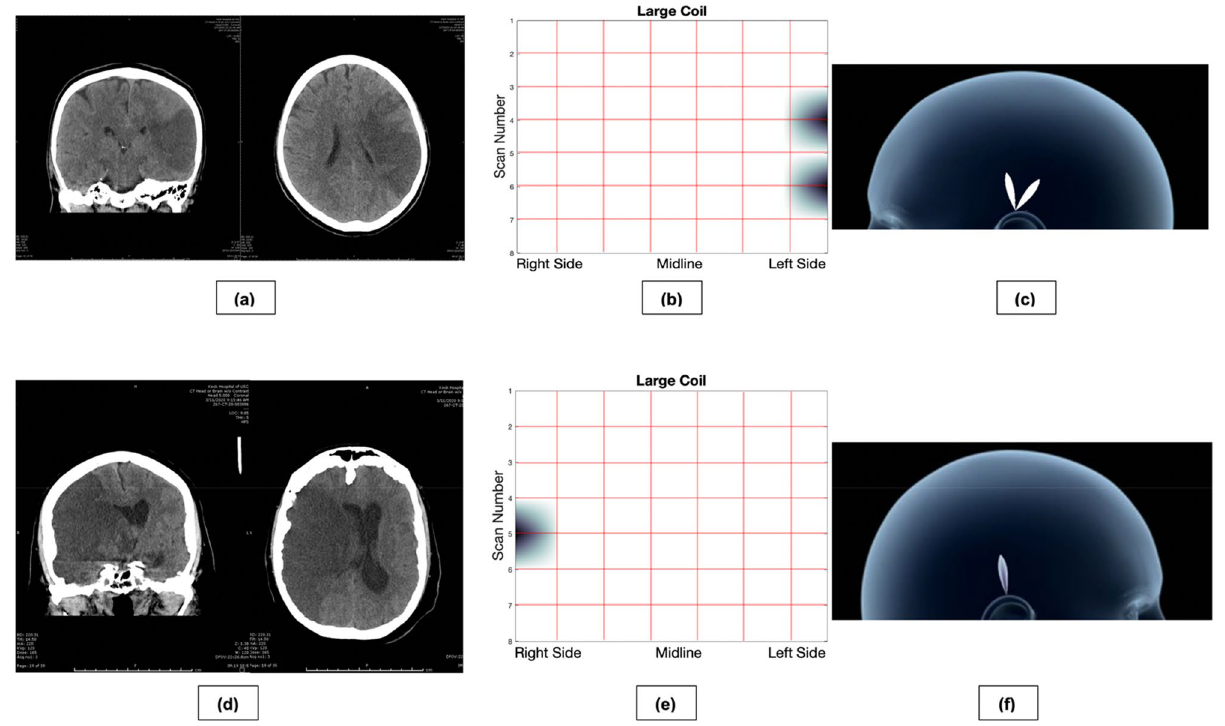
Figure 5. CT imaging, 2D ECD sensor imaging, and 3D ECD sensor imaging for two ischemic stroke patients. The 2D images were produced by continuously scanning across the 8 scanning rows and then averaging each row into 8 equidistant points, with interpolation, to create an 8 × 8 heatmap. As such, lesions are shown on the vertices of the heatmap if detected. To create the 3D images, the 2D heatmaps were projected onto a hemispherical head template. ( a ) CT imaging showing left MCA ischemic stroke. ( b ) Two-dimensional data gathered from ECD sensor scanning from Patient #4. ( c ) Three-dimensional projections of the maximal point of the lesion. ( d ) CT imaging showing right MCA ischemic stroke. ( e ) Two-dimensional data gathered from ECD sensor scanning from Patient #5. ( f ) Three-dimensional projections showing the maximal region of the ischemic